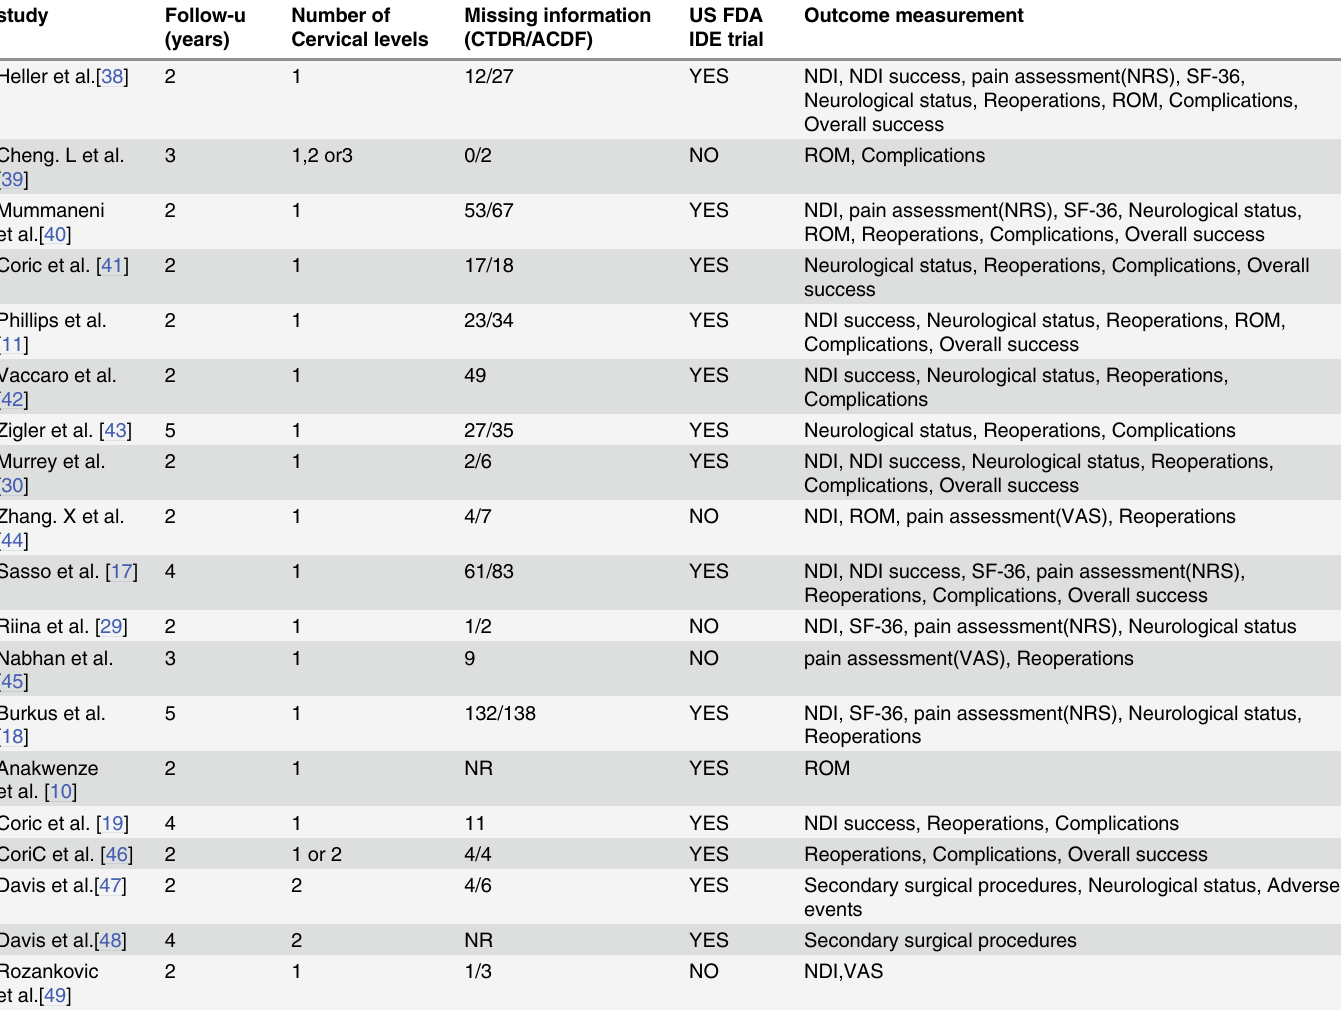
Table 2. Characteristics and clinical outcome measurements of the articles included in this